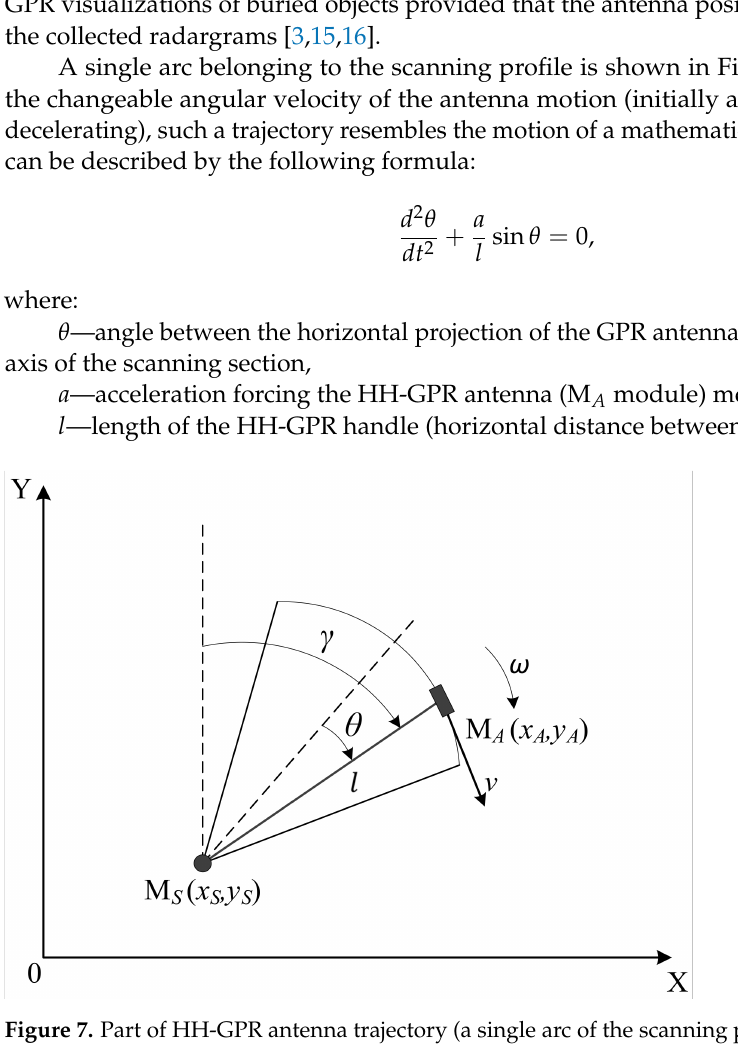
Figure 7. Part of HH-GPR antenna trajectory (a single arc of the scanning